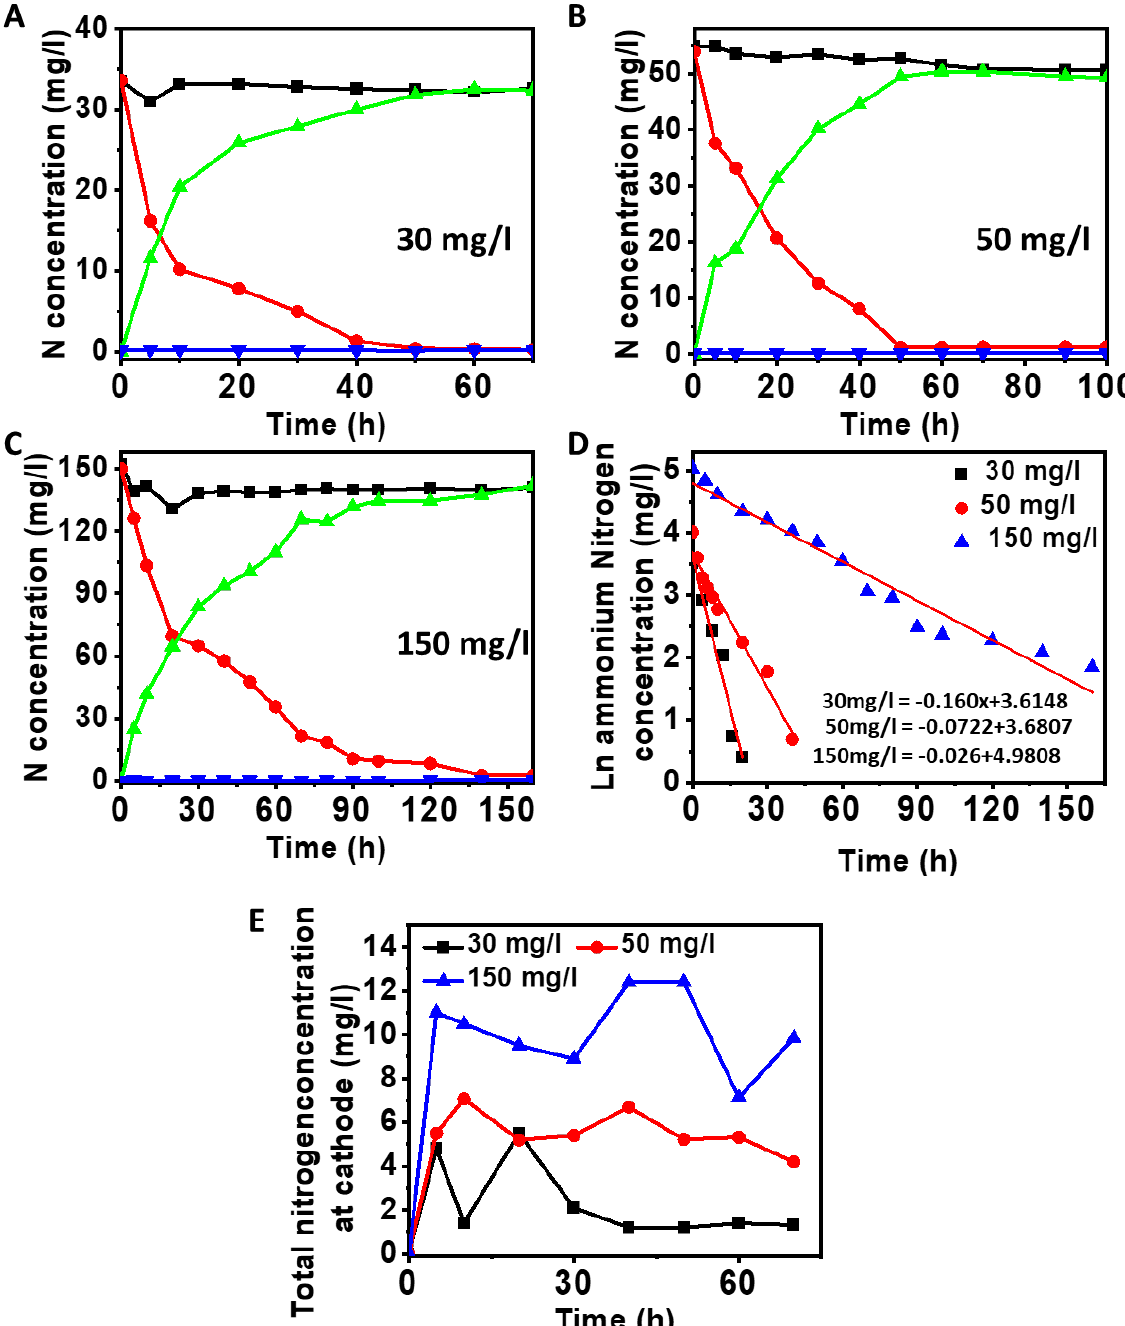
Figure 5. The variation in N concentrations with variation in ammonium nitrogen loadings. In this case, 30 mg/L ( A ), 50 mg/L ( B ), and 150 mg/L ( C ). The linear regressions ( D ) noted at different load- ings of ammonium nitrogen with an applied voltage of 1.5 V. The diffusion of nitrogen ions in terms of total nitrogen ( E ) from anode to